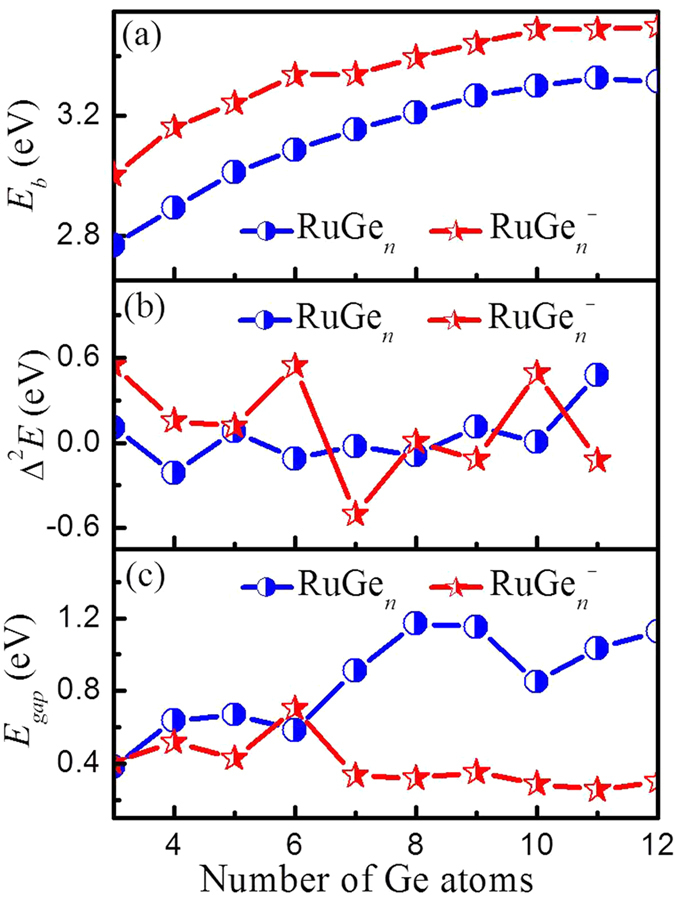
Size dependences of average binding energies (Eb), second order difference (Δ2E) and HOMO–LUMO gaps (Egap) for the global minimum RuGen−/0 (n = 3–12) clusters.